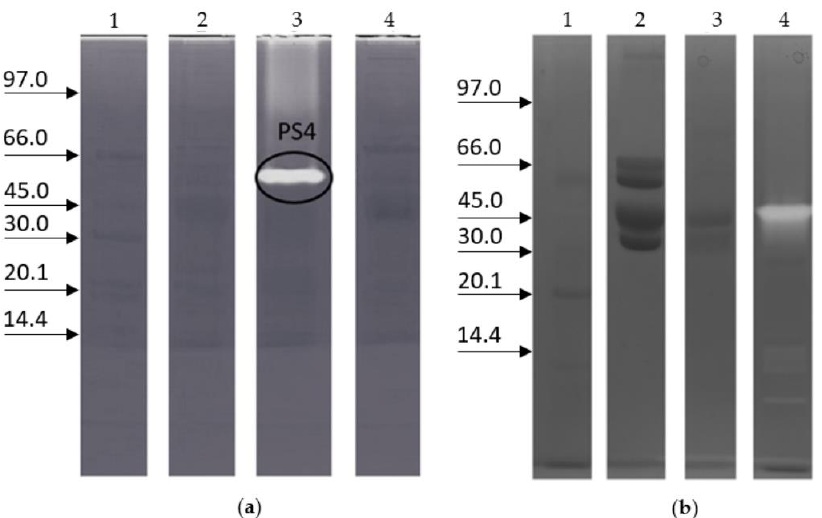
Figure 1. Proteolytic activity in queen-fate larvae and worker-fate larvae of honeybees. ( a ) Zymogra- phy (12% T, 2.6% C): lane 1, low marker range in kDa; lane 2, protein extract of queen-fate larvae, 0.15 g; lane 3, protein extract of worker-fate larvae, 0.15 g (5th larval instar), the highlighted band represents the protein PS4; lane 4, protein extract of queen-fate larvae, 0.18 g (5th larval instar). ( b ) Zymography (10% T, 2.6% C): lane 1, marker low range; lane 2, royal jelly extract; lane 3, pollen extract; lane 4, protein extract of worker-fate larvae .